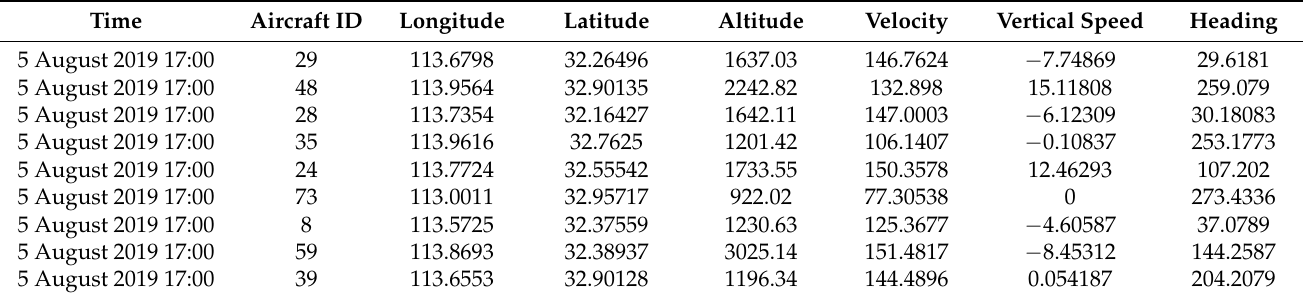
Table 4. An example of the processed sample.